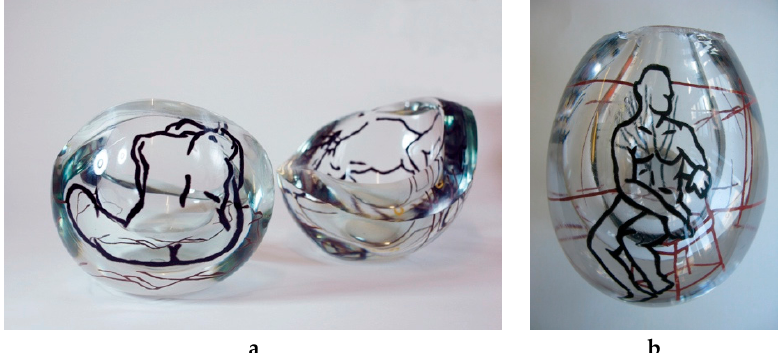
Figure 13. ( a ) ‘ Life drawing glass ’ 1 and 2 (2011). Cristalica glass body with Kugler powder glass (opaque yellow (K2078-Canary yellow), opaque red (K2124-Poppy red) and opaque black (K2095-Opal black), 120 mm (H) × 140 mm (W) and 120 mm (H) × 155 mm (W)). ( b ) ‘ Life drawing glass ’ 3 (2011) Cristalica glass body with Kugler powder glass (opaque yellow (K2078-Canary yellow), opaque red (K2124-Poppy red) and opaque black (K2095-Opal black), 160 mm (H) × 120 mm (W)).